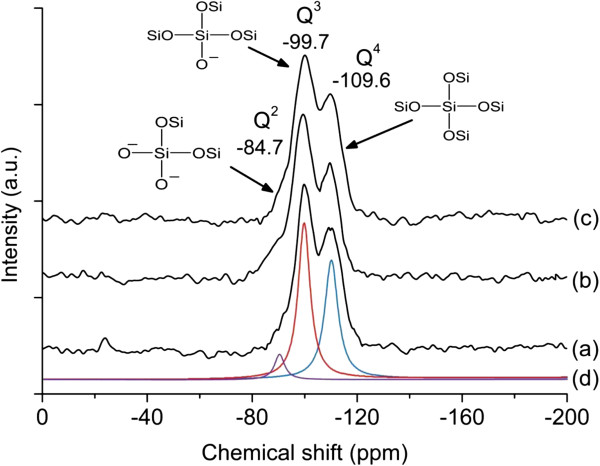
29Si MAS NMR spectra of as-synthesized (a) M-1, (b) M-2, (c) M-3, and (d) deconvolution of spectrum M-1.